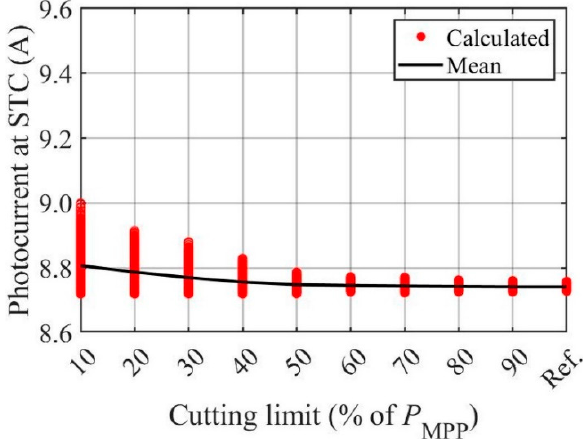
Figure 6. Fitted photocurrent values during the 40 min measurement period converted to STCs as a function of the cutting limit based on MPP power.